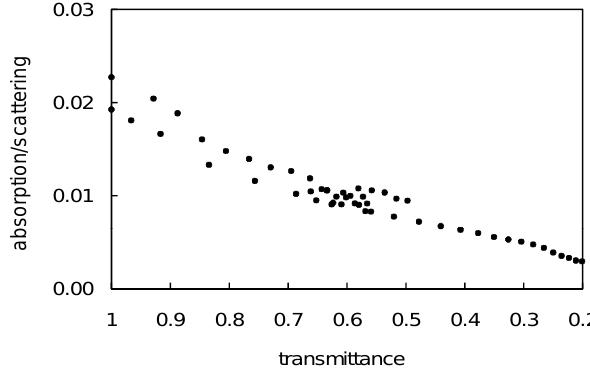
Fig. 12. Cross sensitivity of absorption to particle scattering as a function of filter transmittance for